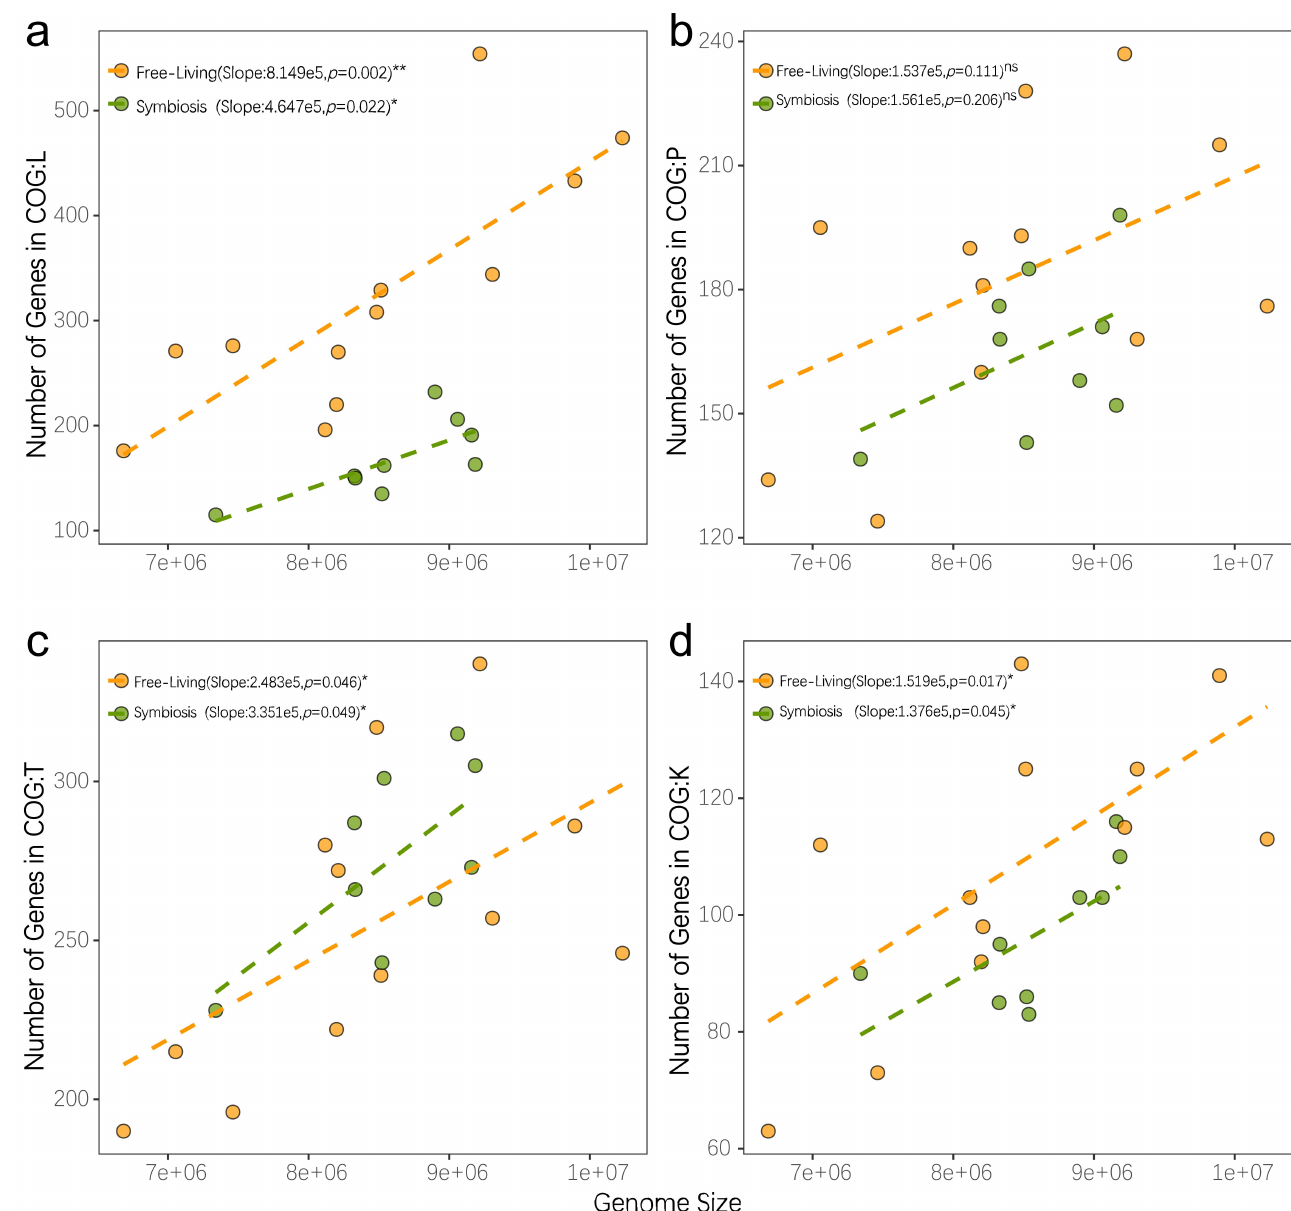
Figure 7. Nostoc genome enriches different genome functions under different lifestyles. Yellow point indicates the genome with free-living lifestyle and green point for symbiotic lifestyle. The dashed line shows the linear regression relationship between genome size and the number of coding genes in each COG type. Each figure indicates genes functions belonging to ( a ) COG L Replication and repair, ( b ) COG P Inorganic ion transport and metabolism, ( c ) COG T Signal Transduction, and ( d ) COG K Transcription.